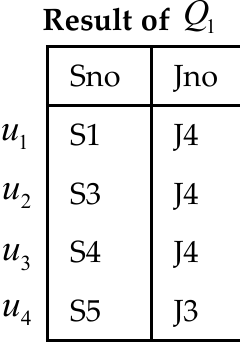
Figure 2. The query Q 1 and its output.